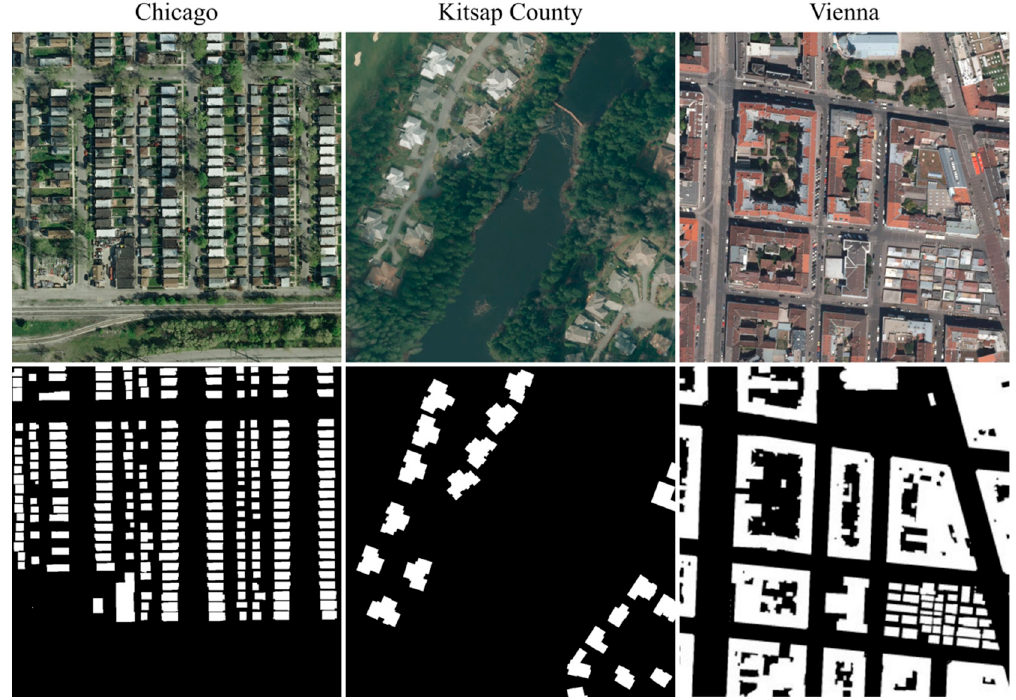
Figure 1. Illustration of the Inria dataset showing three sample image patches and corresponding ground truth for Chicago, Kitsap County, and Vienna (source [29]).